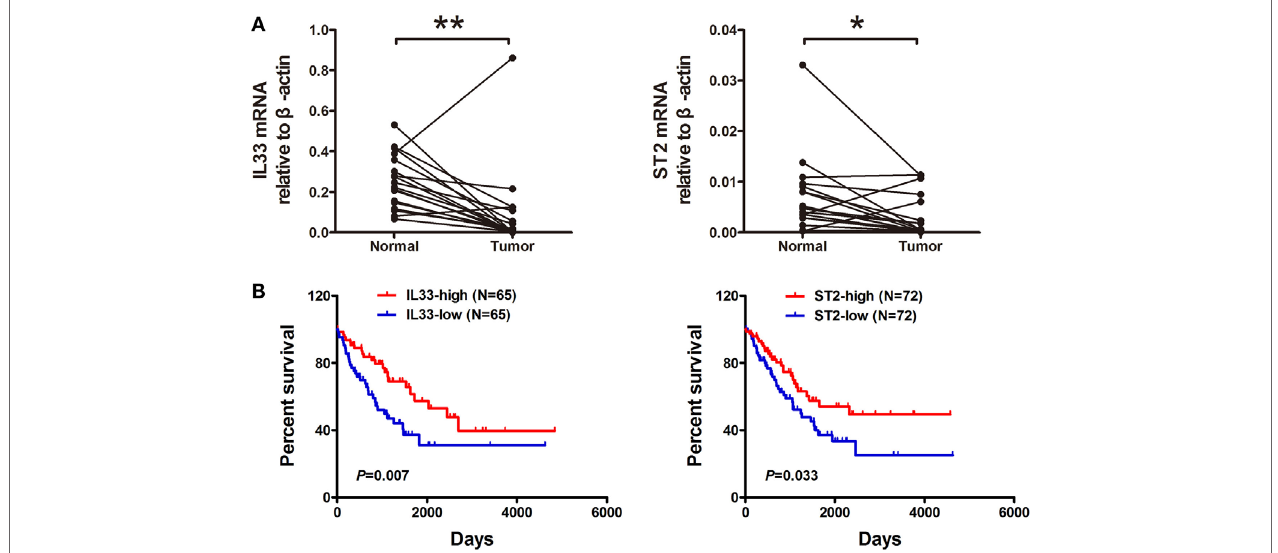
FigUre 1 | Expression and prognostic significance of IL-33 and ST2 in soft tissue sarcoma. (a) The expression of IL-33 and ST2 in tumor tissues was lower than those in adjacent normal tissues. A total of 18 pairs of sarcoma and adjacent normal tissue specimens were collected and used for real-time PCR assays for IL-33 and ST2 expression. The expression data were normalized to the geometric mean of the housekeeping gene β -actin. * P < 0.05, ** P < 0.01 using paired t -test. (B) Higher transcriptional levels of IL-33 and ST2 were associated with a better outcome. Transcriptional sequencing and survival data from patients with soft tissue sarcoma were obtained from the publicly accessible The Cancer Genome Atlas portal, and overall survival analysis was evaluated by Kaplan–Meier and Log-rank